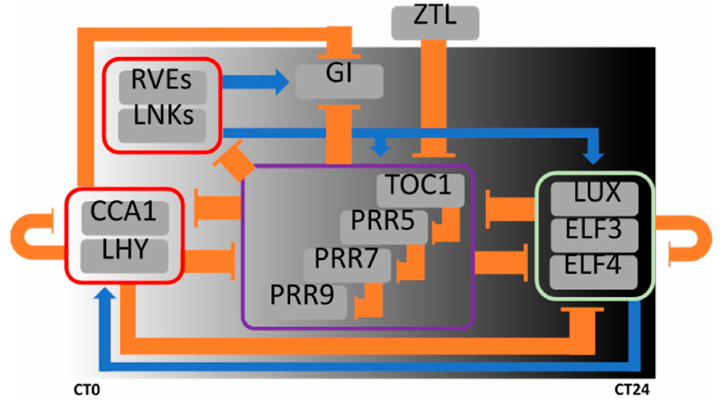
Figure 1. Plant circadian clock. Core components of the circadian oscillator in A. thaliana and its regulatory loops network. The position in the chart of each component is relative to the time of maximal expression/activity along the day. CT: circadian time (CT0 is defined as the light on-set). Blue lines indicate activation and orange lines indicate repression. Pur- ple box: PRRs components (PRR9, PRR7, PRR5 and TOC1). Green box: evening complex “EC” members (LUX, ELF3 and ELF4). Red box morning elements: CCA1/LHY and RVEs/LNKs. This is a simplified scheme and it does not include all of the oscillator components. LHY: LATE ELONGATED HYPOCOTYL; CCA1: CIRCADIAN CLOCK ASSOCIATED1; RVE: REVEILLE; LNK: NIGHT LIGHT-INDUCIBLE AND CLOCK-REGULATED; PPR: PSEUDO RESPONSE REGULATOR; TOC1: TIMING OF CAB EXPRESSION1; ZTL: ZEITLUPE; GI: GIGANTEA; ELF3/4: EARLY FLOWERING 3/4; LUX: LUX